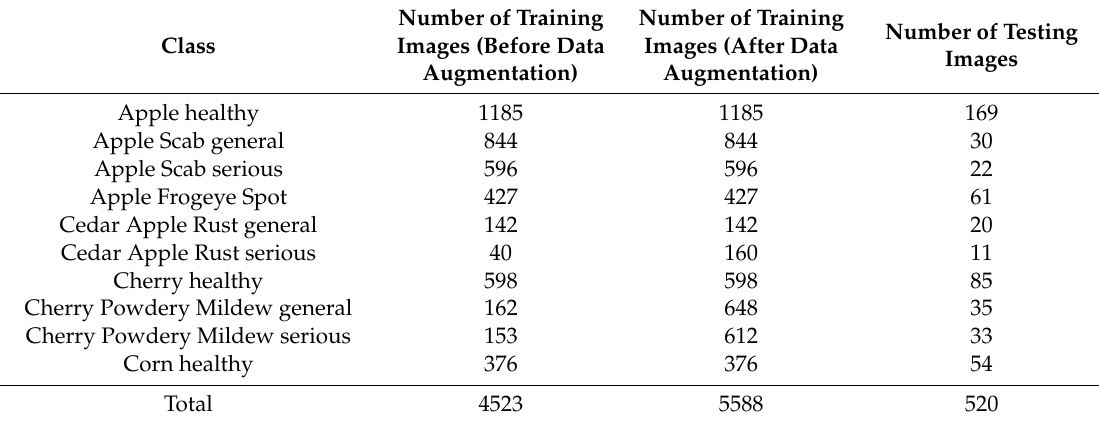
Table 1. Statistics of the plant leaf disease dataset.